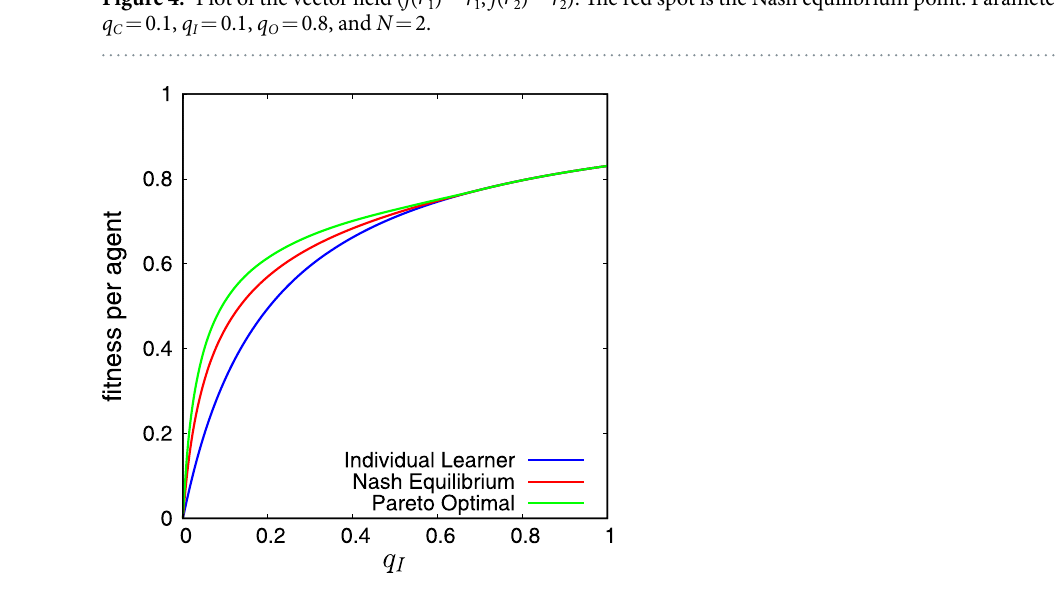
Figure 5. Plots of w I , w N , and w P as functions of q I . Parameters: N = 10, q C = 0.2, q O = 0.8. Thus, − − .  N q a N ((